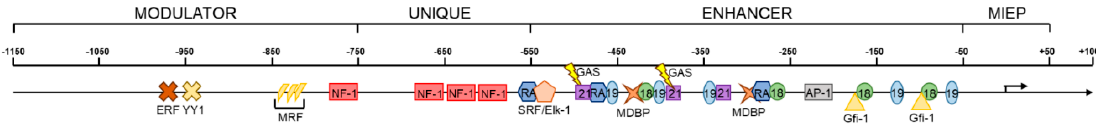
Figure 4. Diagram of cellular transcription factor binding to the HCMV major immediate early promoter (MIEP). The major immediate early core promoter, enhancer, unique region, and modulator are shown. Relative locations of binding sites for activating and repressive cellular transcription factors are shown. Repeat elements are labeled with the number of base pairs repeated in each sequence. The 18-bp repeats bind NF- κ B/rel, the 19-bp repeats bind CREB/ATF, and the 21-bp repeats bind SP-1, YY1, and ERF.